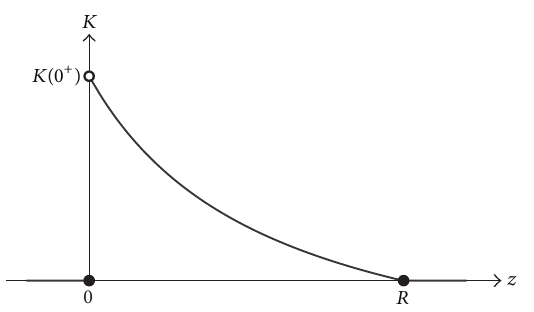
Figure 2: Prototype of interaction kernel 𝐾 complying with Assumption